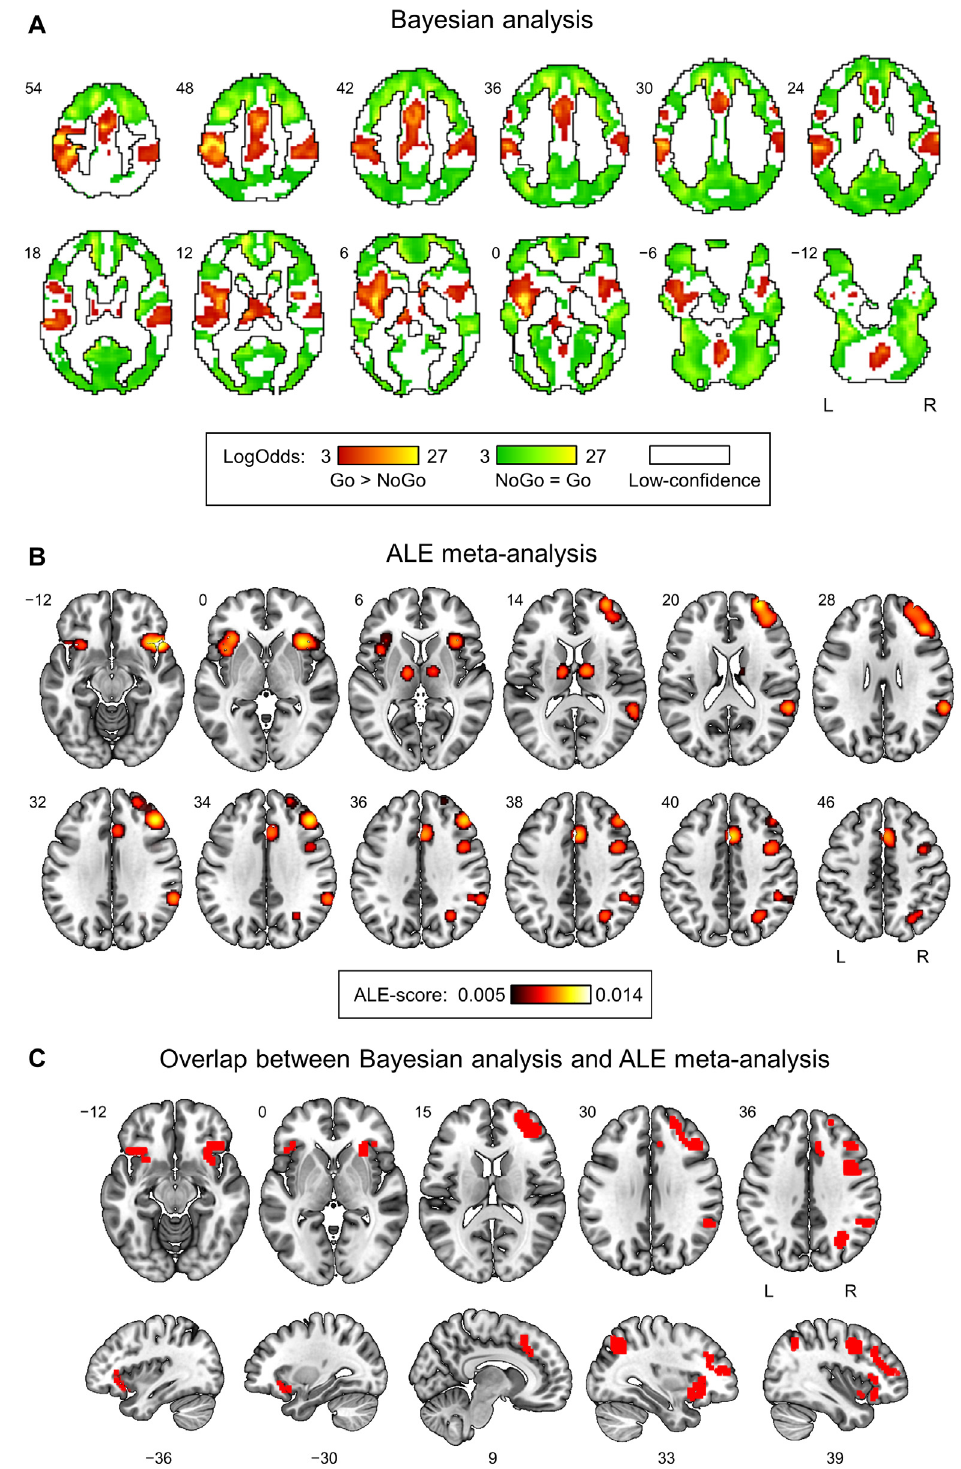
Figure 2. Non-selective response inhibition in the OCD group. ( A ) Results of Bayesian analysis of fMRI data from the patients with OCD. The “Go > NoGo” effect is shown in red. The “NoGo > Go” effect was not detected. The null “NoGo = Go” effect is indicated in green. The “low confidence” voxels are shown in white. ( B ) The result of the meta-analysis of 20 fMRI studies using equal probability Go/NoGo tasks (“50/50% Go/NoGo blocks > 100% Go-control blocks” contrast) from Masharipov et al. (2022) [50]. ( C ) Overlap between the results of Bayesian analysis (“NoGo = Go”) and the ALE meta ‐ analysis.